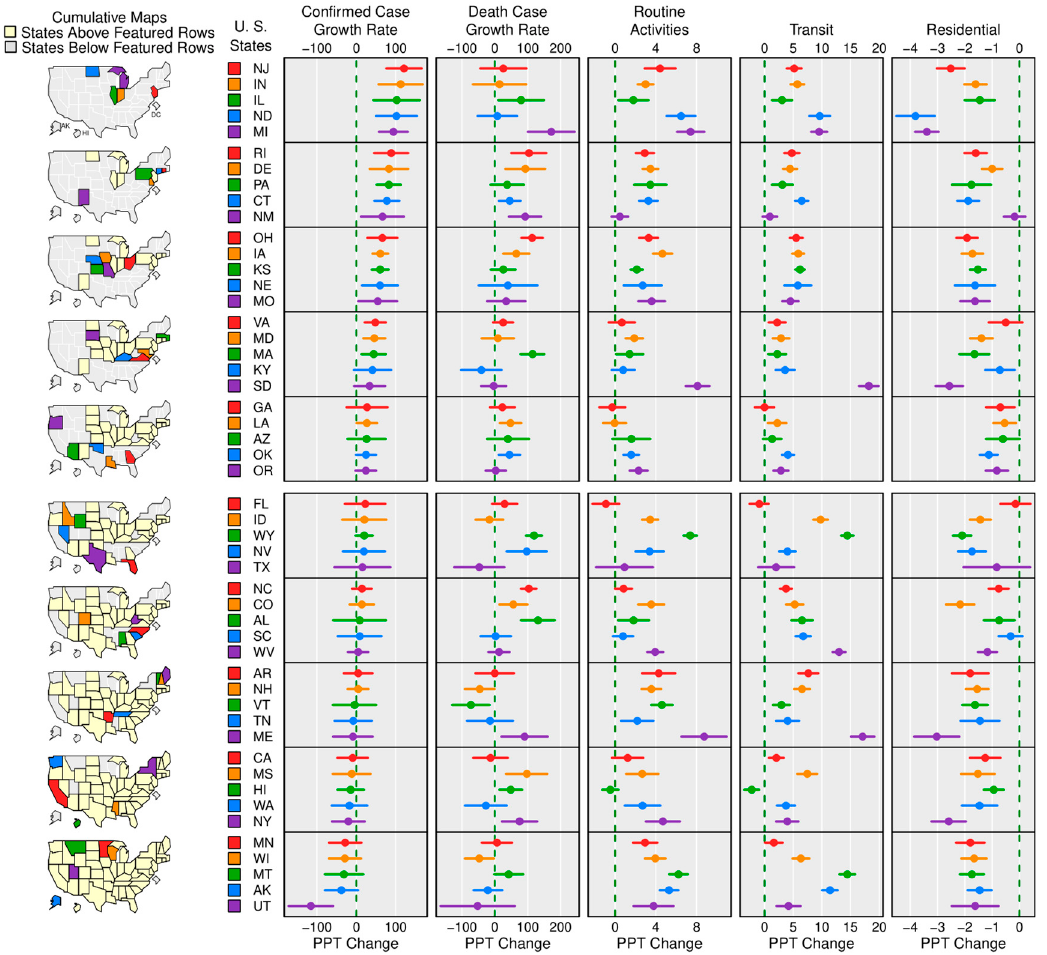
Figure 3. Counterfactual state-specific time trends in absence of seven social distancing policies.